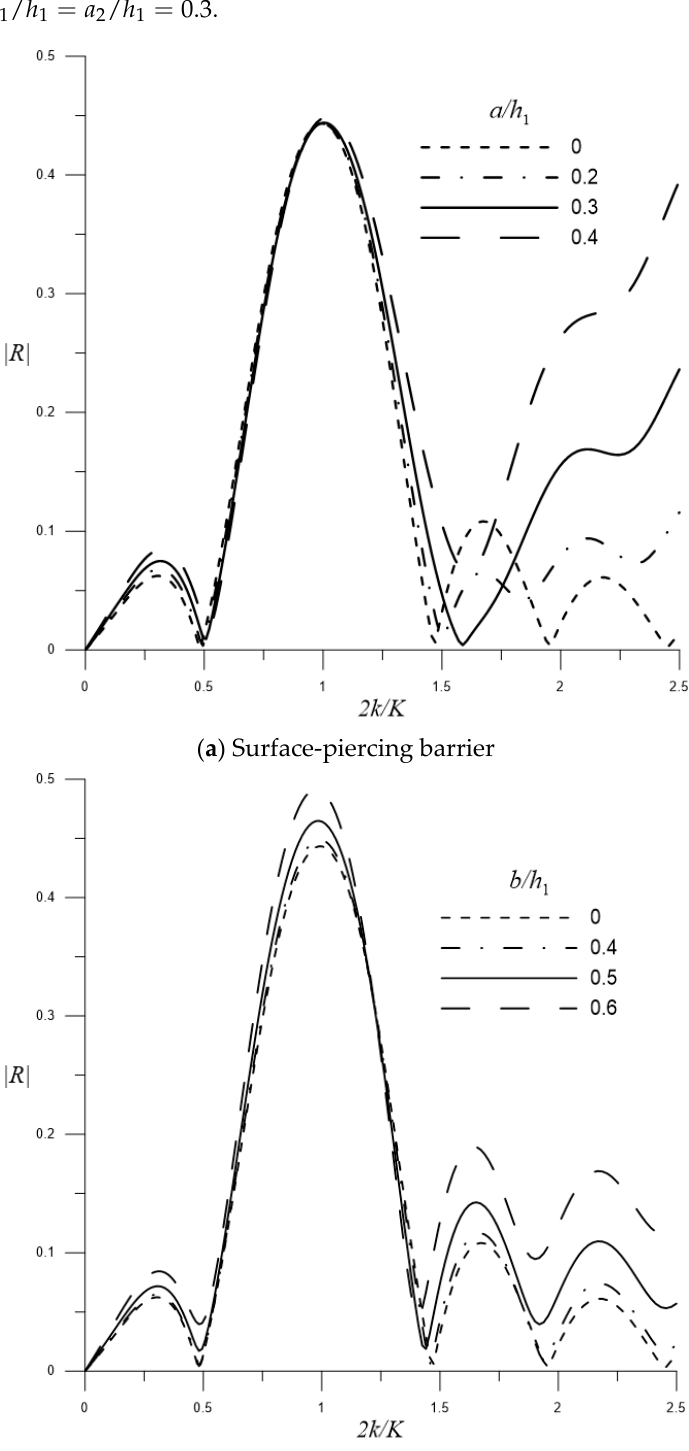
Figure 14. Reflection coefficient | R | varying against 2 k / K by a single ( a ) surface-piercing and ( b ) bottom ‐ standing barrier with different barrier lengths.